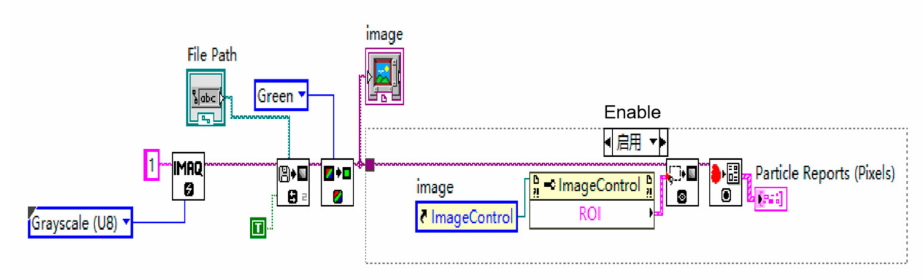
Figure 7. Block diagram of calculating pixel value in